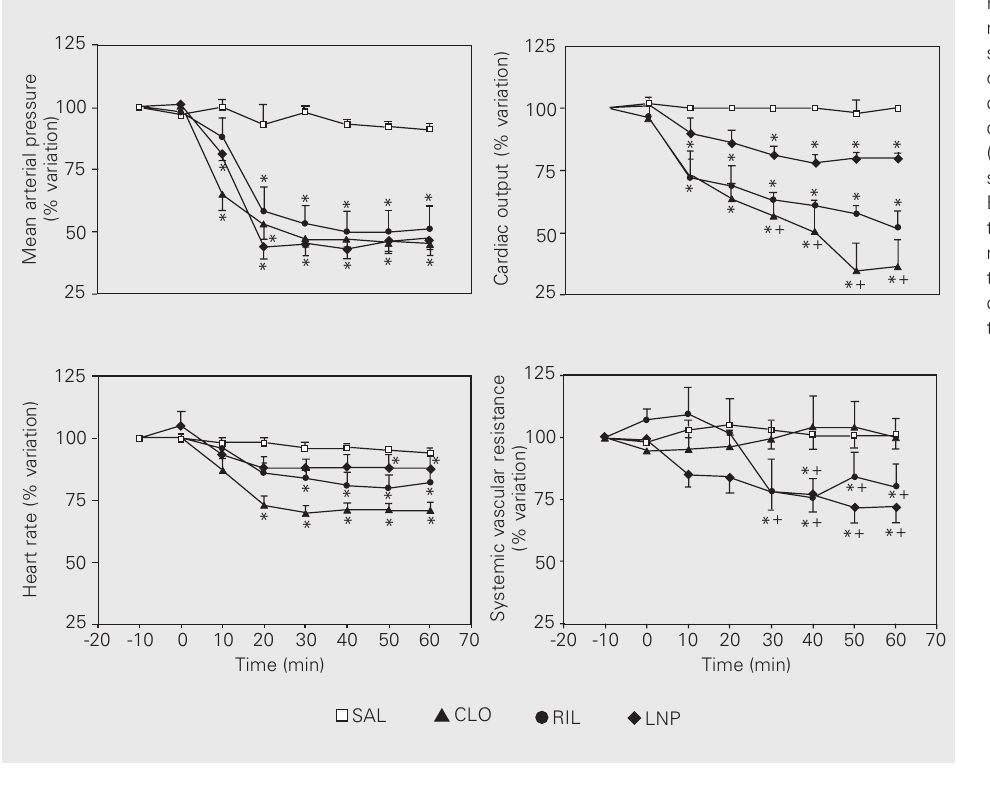
Table 1. Maximum effects of the intracisternal injection of clonidine (1 µg), or LNP 509 (60 µg) on the macrohemodynamic parameters of pentobarbital-anesthetized spontaneously hypertensive rats.